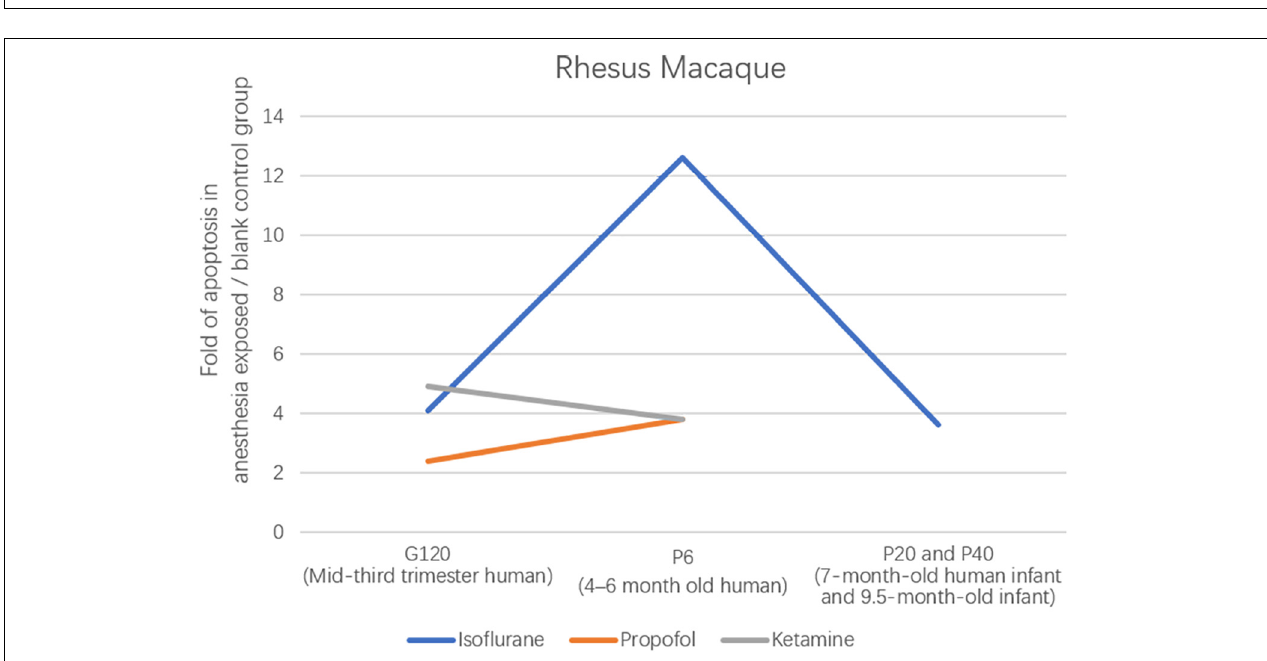
FIGURE 6 | Ratio of the total number of apoptotic profiles (neurons + oligodendrocytes) in the brains of rhesus monkeys exposed to different anesthetic drugs to the total number in